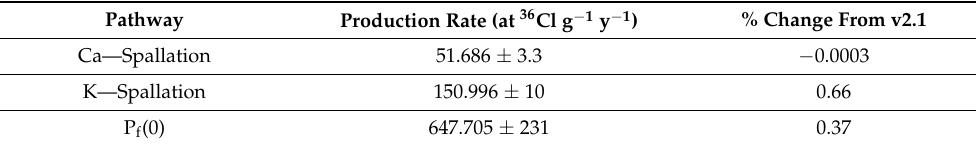
Table 1. 36 Cl production rates for LM scaling model used to calculate these exposure ages. Percent change from Marrero et al. (2021) [30] (CRONUScalc v2.1) is shown for comparison. See Marrero